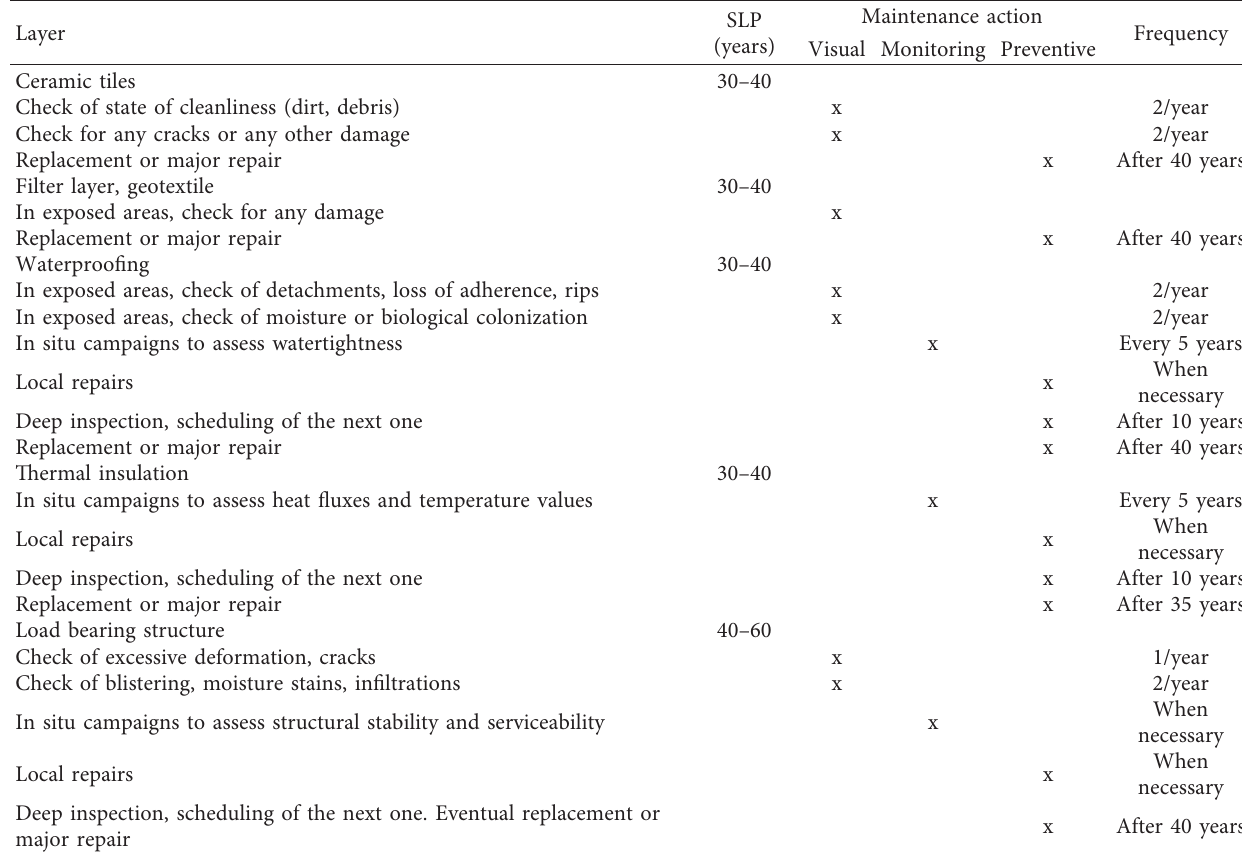
Table 8: Maintenance plan for the conventional flat roof layers and their service life prediction (SLP) (the table is structured by authors upon data from [20] and authors own assessment).